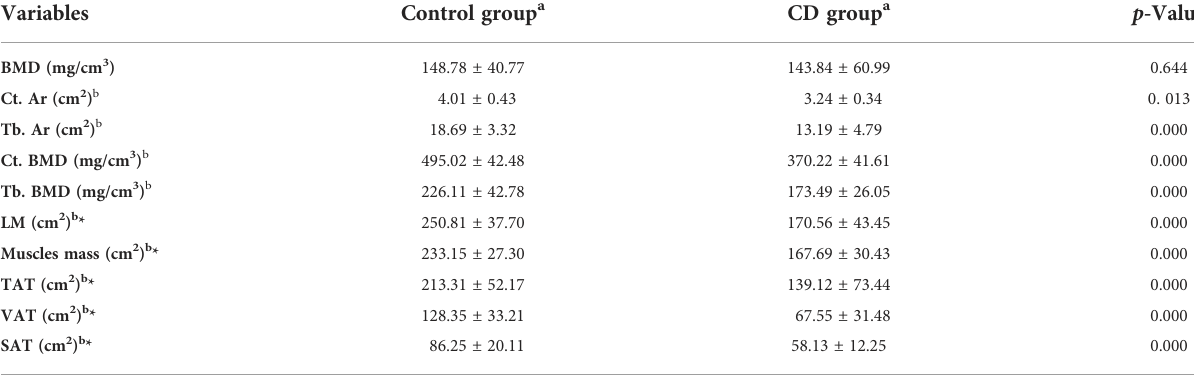
TABLE 1 Clinical characteristics and blood indicators of two groups. Clinical characteristics